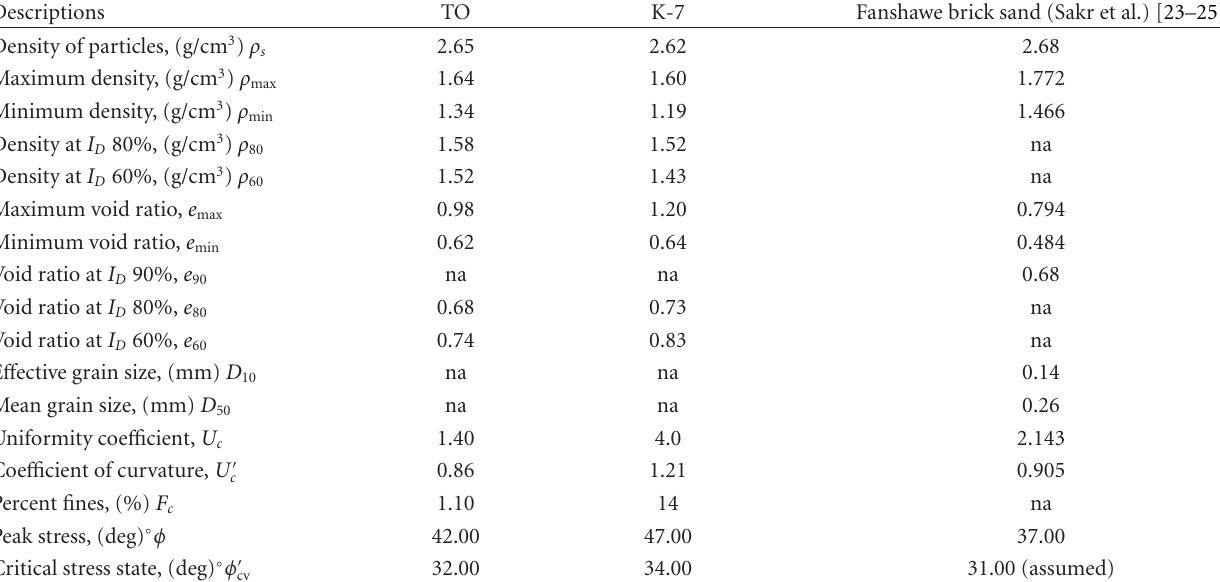
Table 2: Geotechnical properties of di ff erent